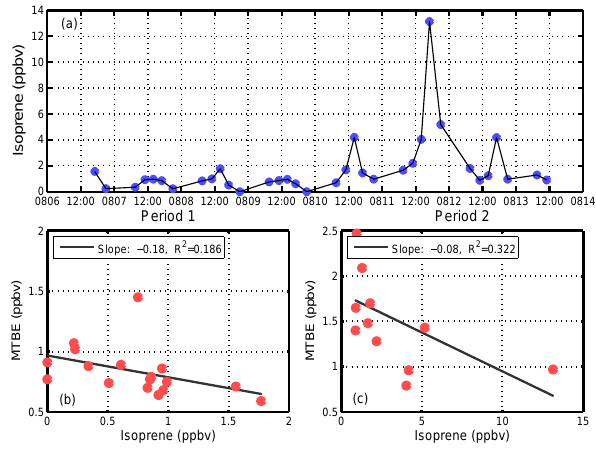
Fig. 6. (a) The time series of isoprene during the sampling pe- riod; (b) Plots of correlations between isoprene and MTBE during period 1; (c) Plots of correlations between isoprene and MTBE dur- ing period